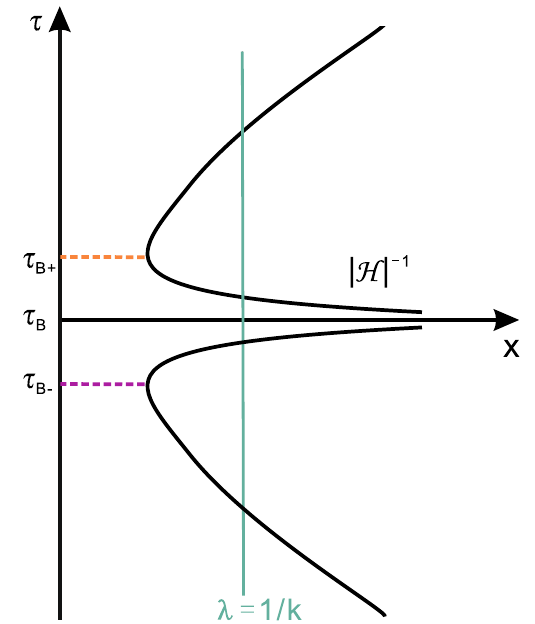
Fig. 6 Space-time sketch of the matter bounce scenario. The vertical axis is conformal time η , the horizontal axis denotes a comoving space coordinate. Also, H − 1 denotes the co-moving Hubble radius. The verti- cal solid green line indicates the wavelength of a particular perturbation mode. As is evident, this mode exits the Hubble radius at some point during the contracting phase and re-enters at a later time in the expand- ing Standard Big Bang